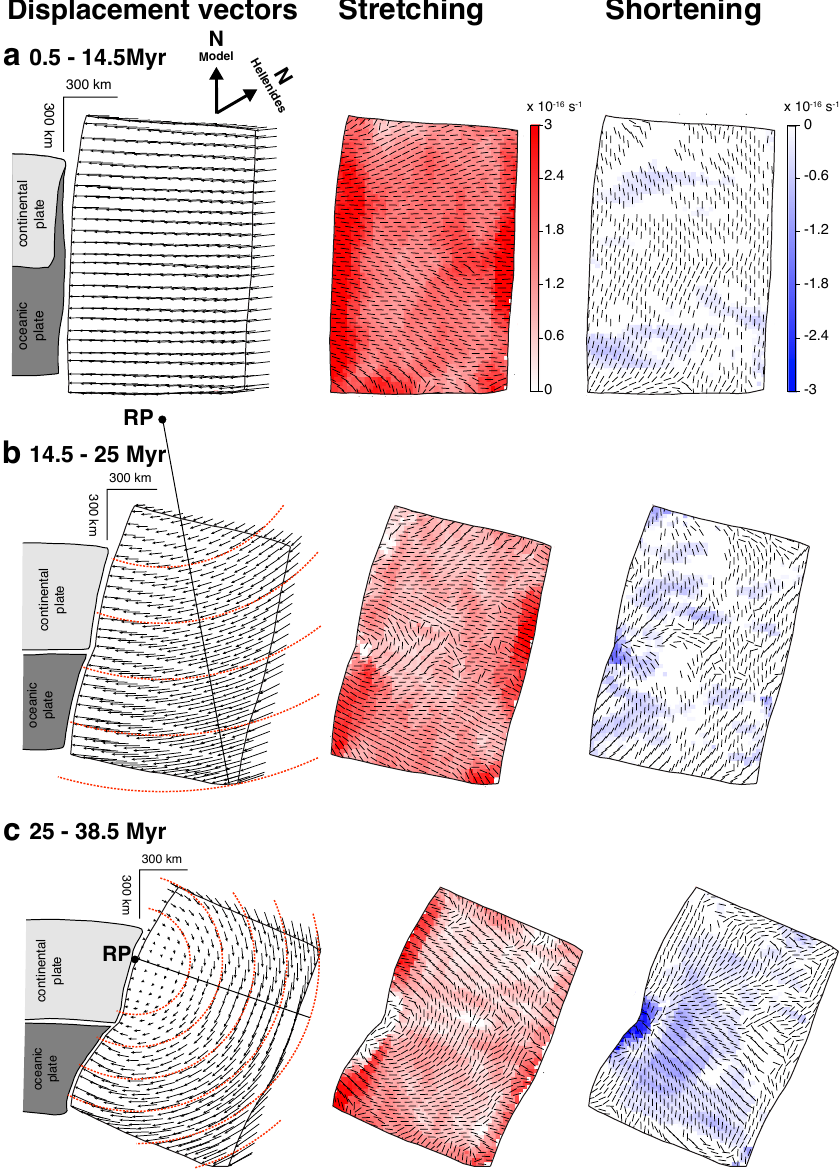
Fig. 7. Motion and deformation of the overriding plate for model 1, (a) between 0.5 and 14.5Myr, (b) 14.5 and 25Myr, and (c) 25 and 38.5Myr after the initiation of subduction. Left panel shows displacements fields for each time interval. Central and right panels show the main directions and rates of stretching and shortening, respectively. RP is for rotation